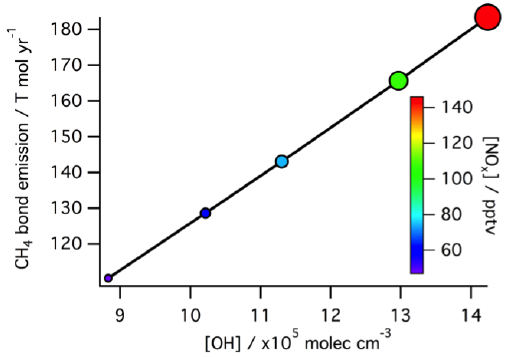
Figure 7. Effective CH 4 emissions as a function of global mean OH concentration for simulations where NO x emissions were changed. Marker size and colour indicate global NO x concentration.